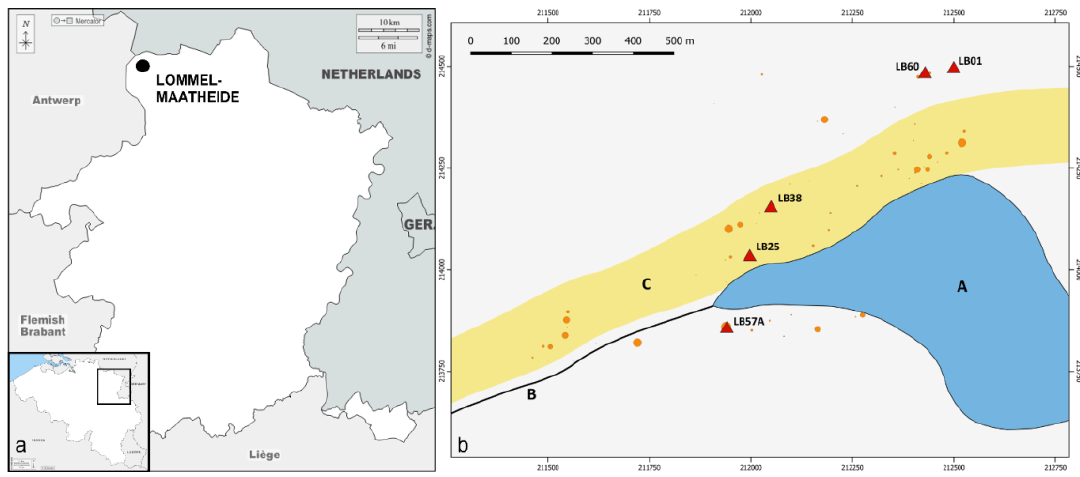
Figure 1. a) The location of Lommel-Maatheide within Northern Belgium. b) Distribution of the concentrations included in this study (surface area of 45ha) and their location within the Late Glacial landscape: shallow lake (A); Rietrijenloop (B); Late Glacial dune